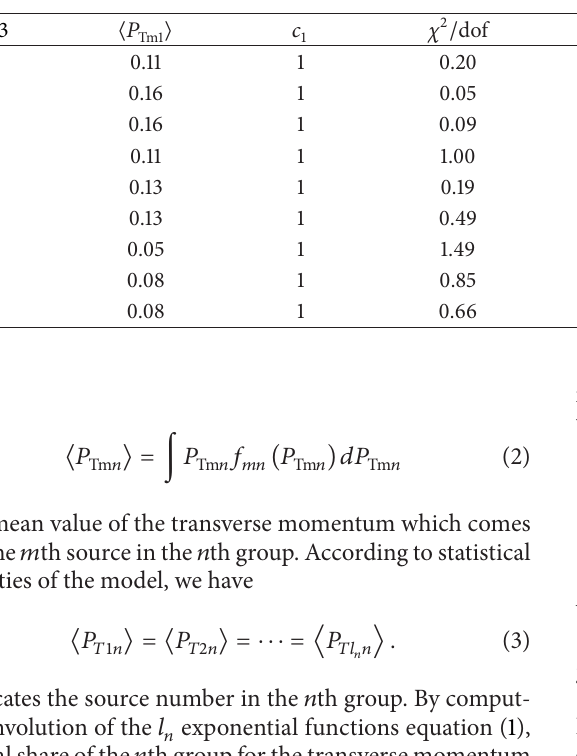
⟩ , 𝑐 1 taken in the fits of Figures 3 and Tm1